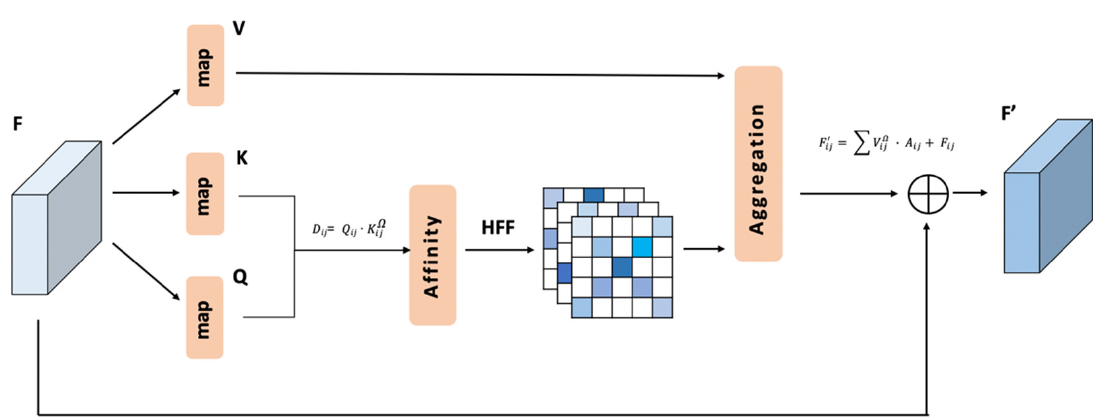
Figure 6. The structure of RCCA module .